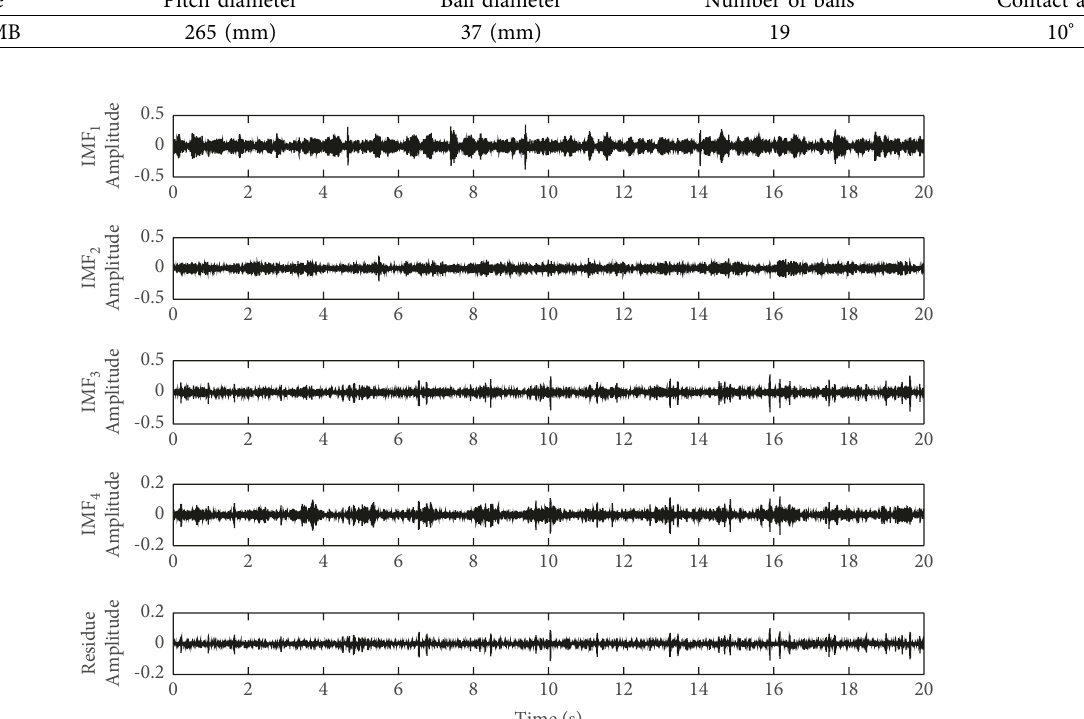
Figure 8: The decomposition results generated by MBMD of a vibration signal from class 3.